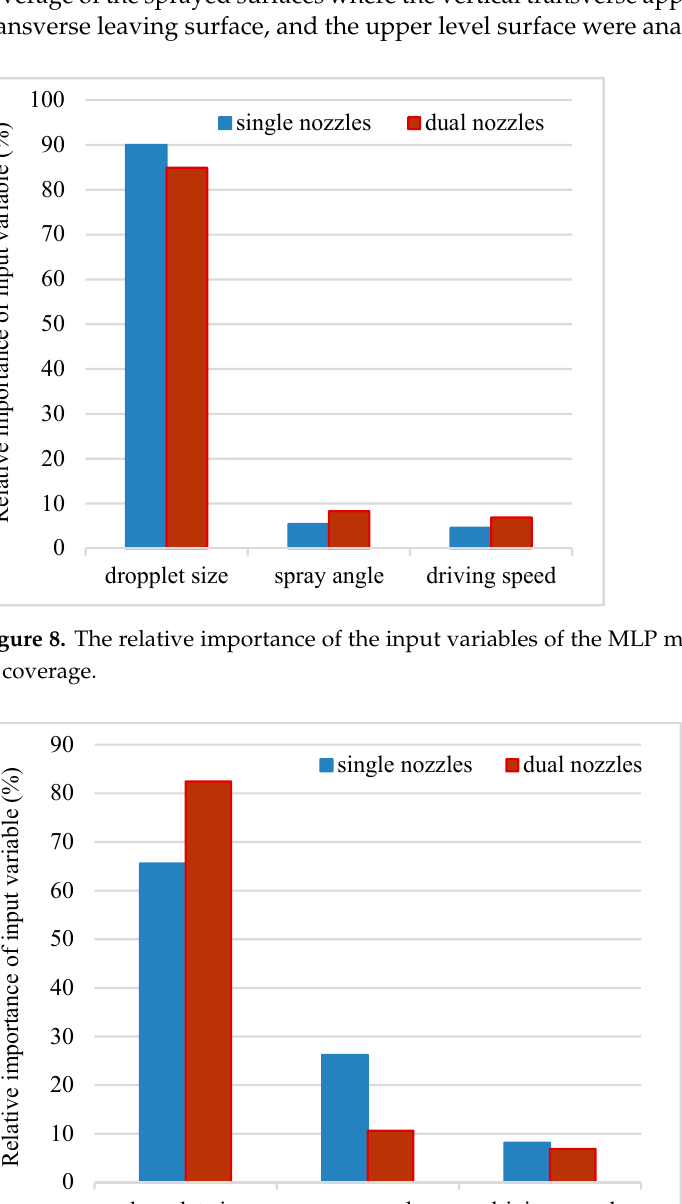
coverage unevenness coefficient for single and dual nozzles. The results are presented in Figures 8 and 9. In the case of both parameters, the average degree of coverage and the coverage unevenness coefficient, the most influencing parameter is droplet size, which depends on nozzle type and pressure. The influence of driving speed and nozzle angular position is significantly lower. These results are in agreement with those presented for the coverage of the sprayed surfaces where the vertical transverse approach surface, the vertical transverse leaving surface, and the upper level surface were analyzed separately [49].